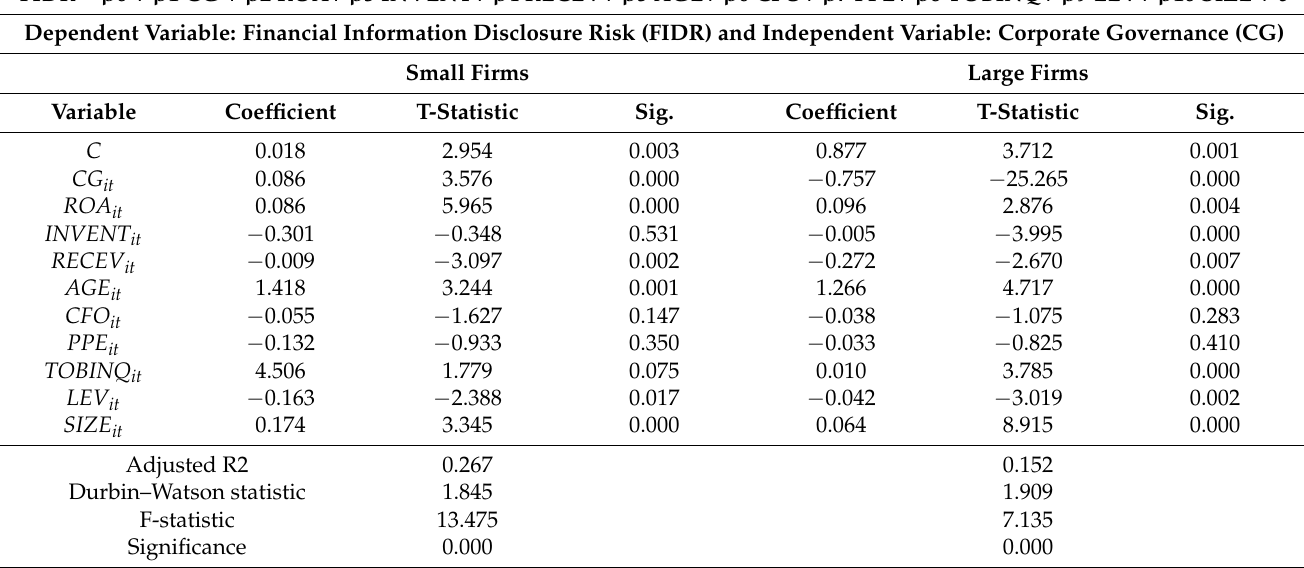
Table 15. The results of the statistical test for the second hypothesis in small and large